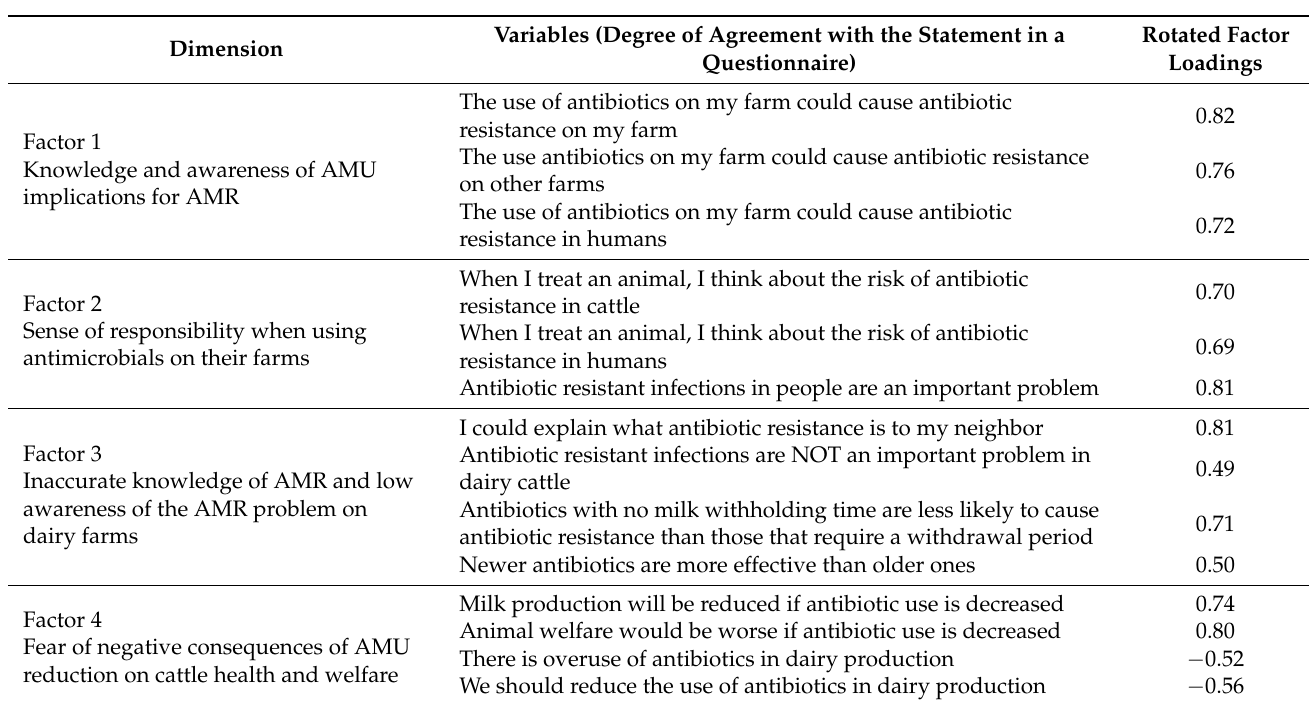
Table 2. Varimax rotated factor loadings > 0.40 from principal components factor analysis of 5- point Likert scale responses by 151 dairy farmers to 15 statements regarding antimicrobial use and resistance. The analysis identified 4 latent dimensions or clusters in the